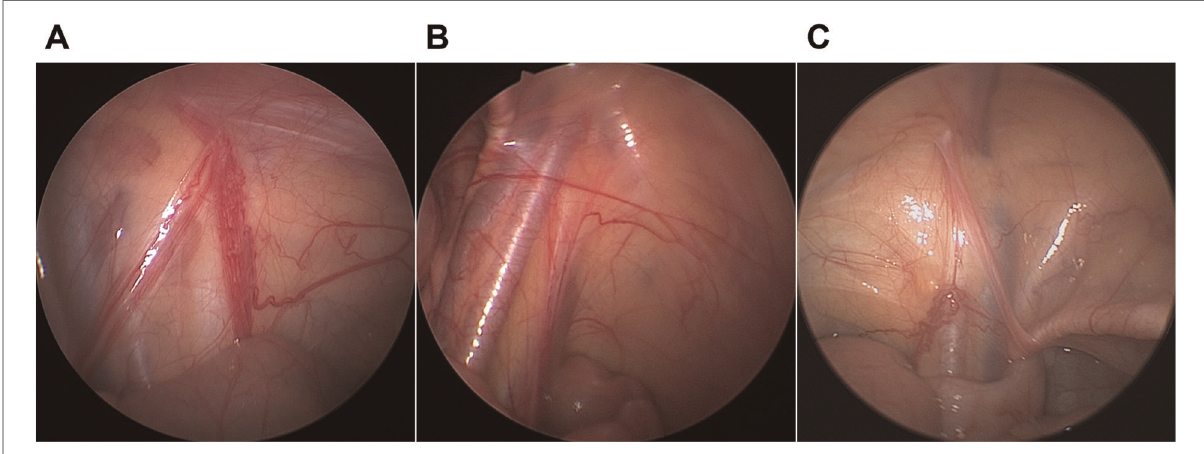
FIGURE 1 Laparoscopic fi ndings in testicular degeneration syndrome. ( A ) Vas and vessels traversing the internal ring. ( B ) Blind-ending vas and vessels. ( C ) Blind- ending vessels with the vas deferens entering the internal